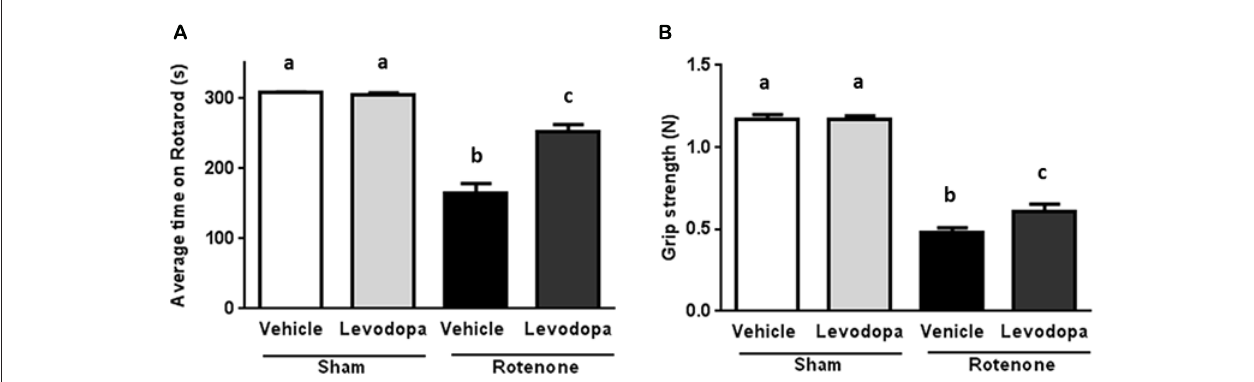
FIGURE 1 | Effects of oral L-3,4-di-hydroxy-phenylalanine (levodopa) treatment (20 mg/kg) on (A) rotarod performance and (B) grip strength test in sham and rotenone treated groups of mice. Intrastriatal rotenone injection induced motor dysfunction and grip strength loss. Oral Levodopa treatment had beneficial effects on motor function and grip strength in rotenone treated animals. Data are shown as mean ± SEM. Different letters indicate mean values were significantly different ( p < 0.05).